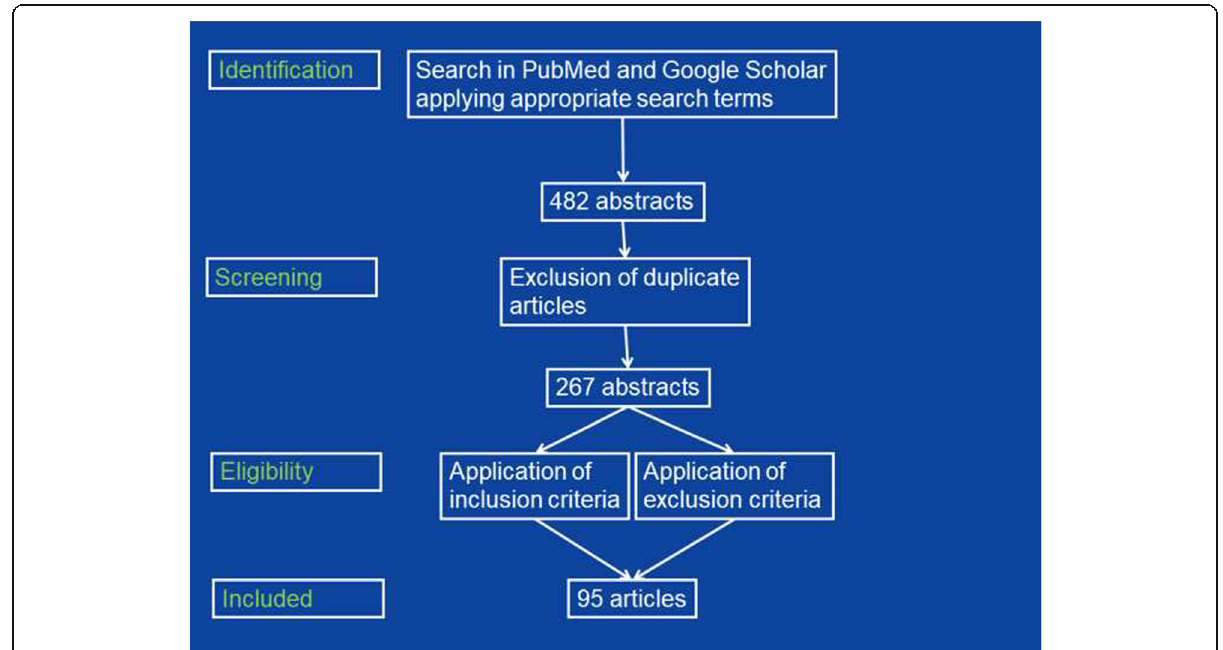
Fig. 1 Flow chart detailing the search protocol and the results after application of inclusion and exclusion